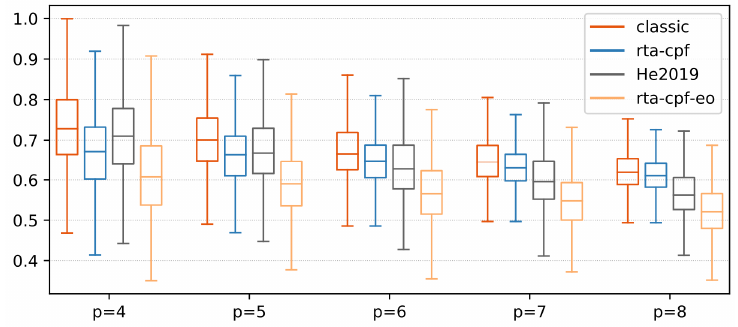
Figure 7. Sensitivity of parallelism parameter ( m = 4).